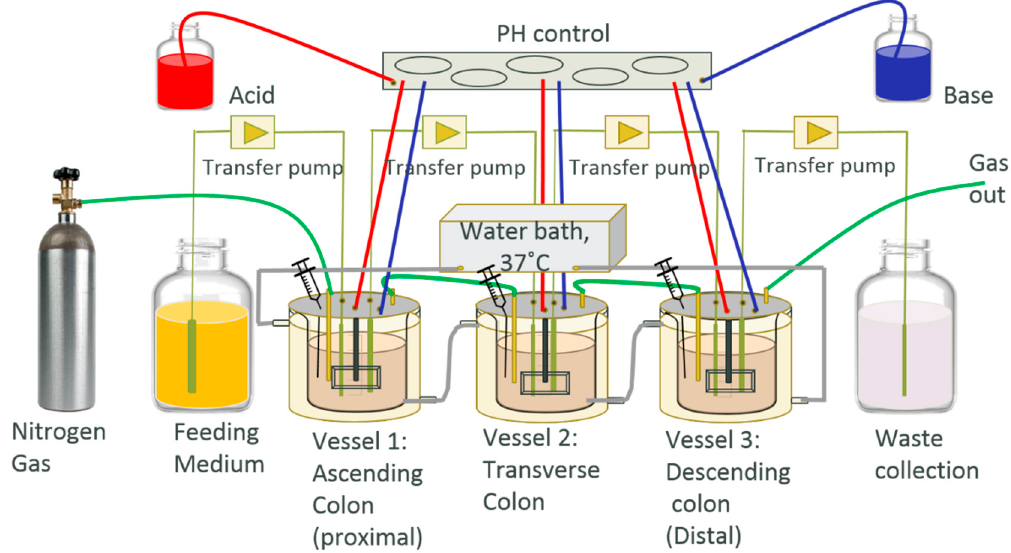
Figure 1. In vitro human colonic model (HCM) contains three vessels. vessel 1 (V1) has a 1 L operating volume at pH 5.6, V2 has a 1.6 L operating volume at pH 6.2, and V3 has a 1.2 L operating volume at pH 6.8, which mimic the environmental condition of the ascending colon, transverse colon and descending colon,